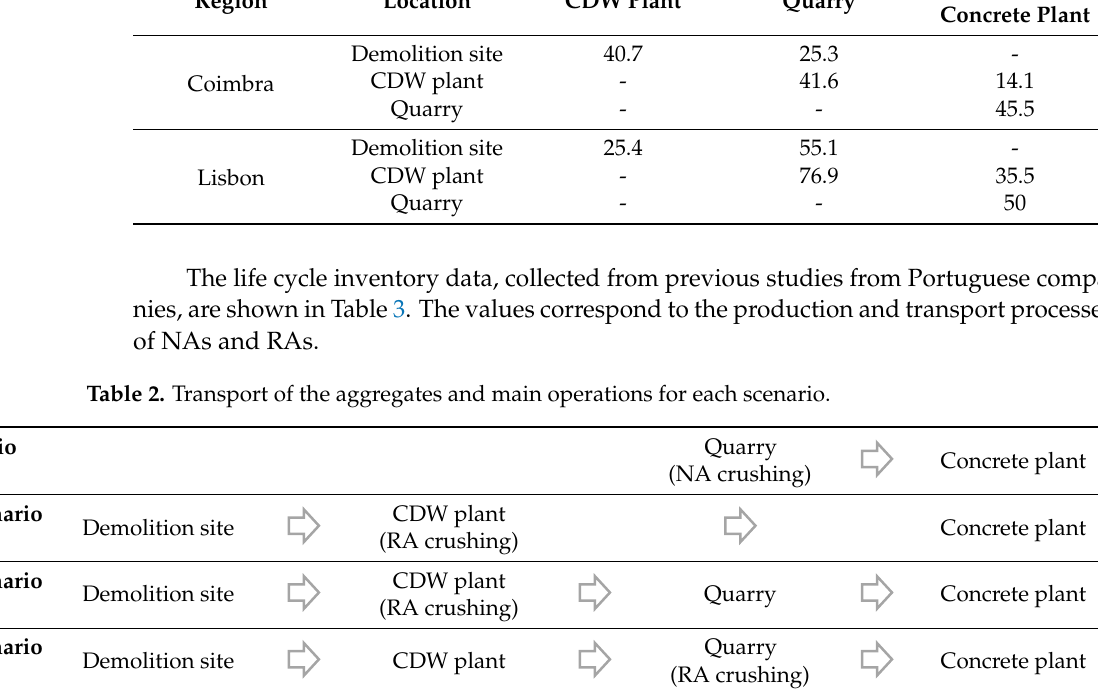
Table 1. Transport distances (in km) of the aggregates through the main operating locations.